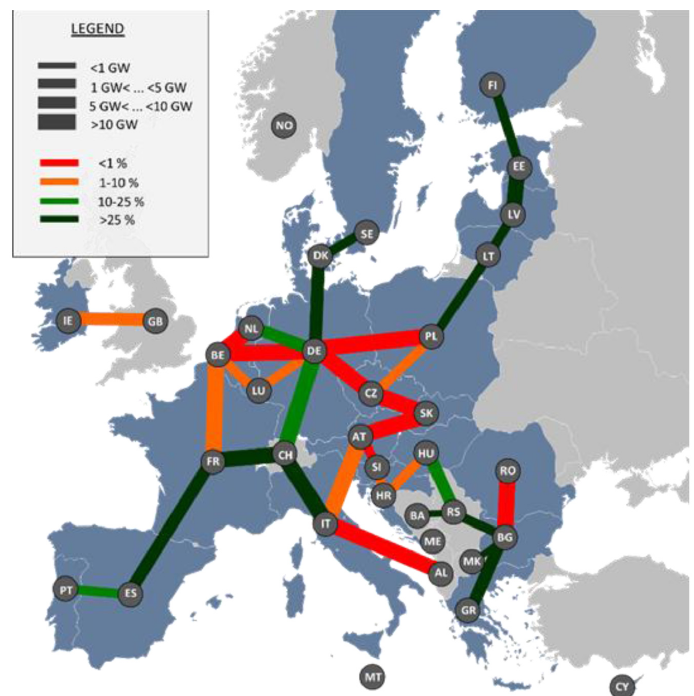
Figure 9. Use rate of gas pipelines in the reference